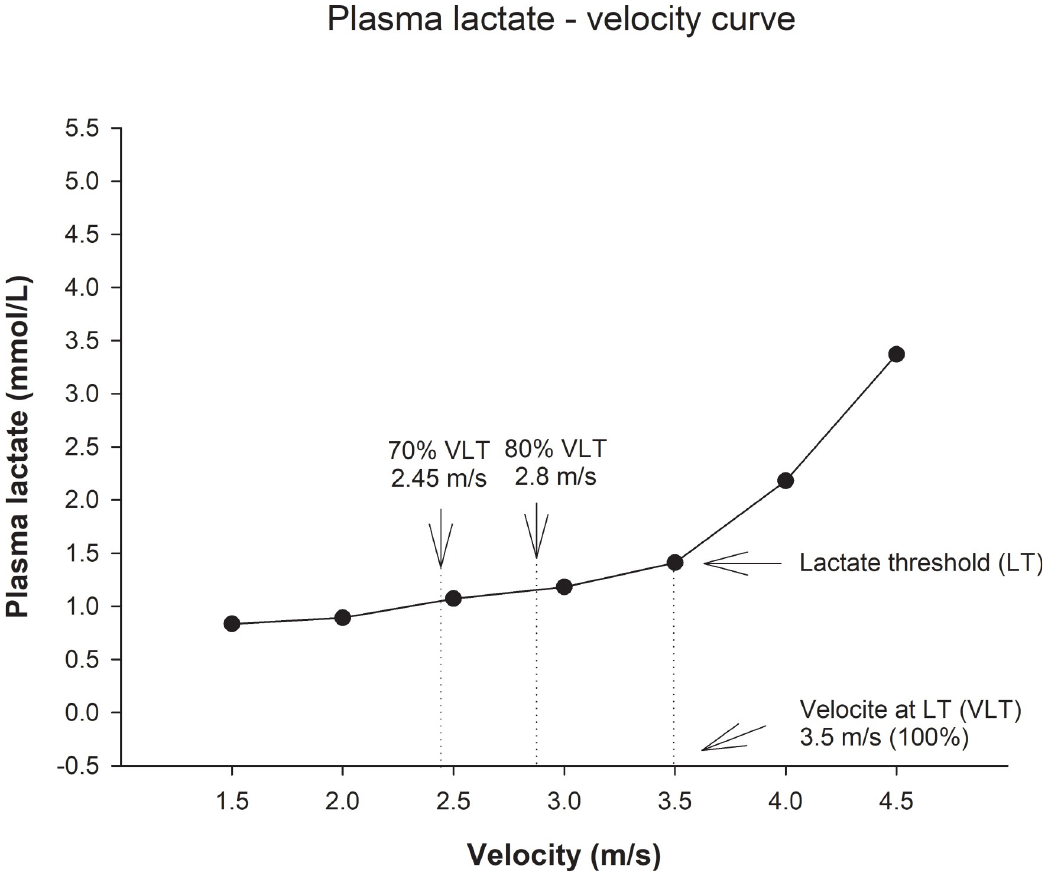
Fig 1. Graphical representation of the typical lactate-velocity curve (LVC) of a representative single Beagle dog submitted to the first incremental exercise test (IET-1). Plasma lactate concentration (mmol/L) vs. velocity (m/s). The increase in plasma lactate concentration corresponds to the lactate threshold (LT). The velocity at the lactate threshold (VLT) was used to prescribe the endurance-training program (ETP) intensity.